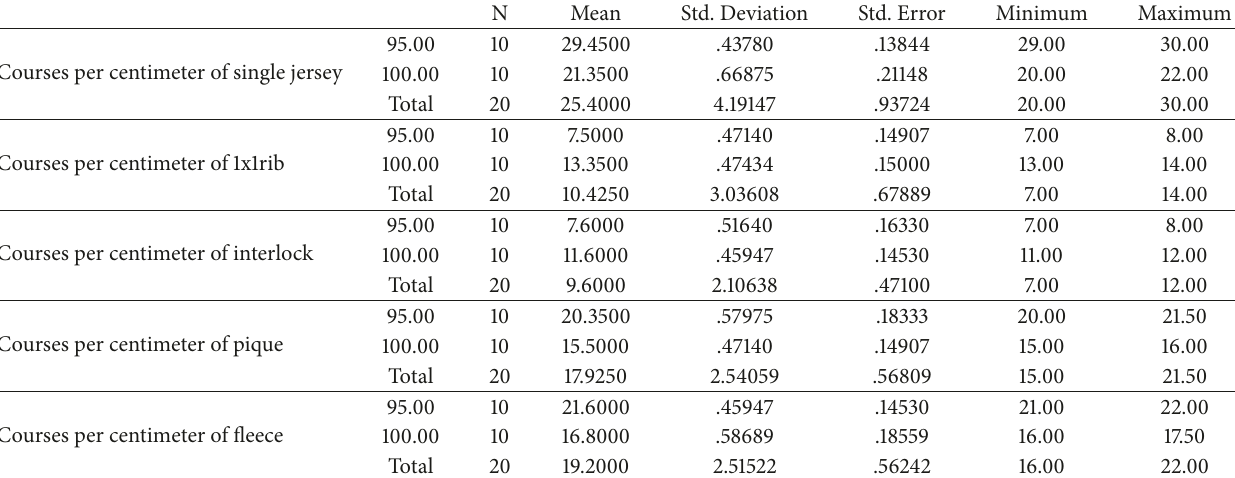
Table 4: Description for the cpc of knitted fabrics made from 100% cotton and cotton/elastane yarns. N Mean Std. Deviation Std. Error Minimum Maximum